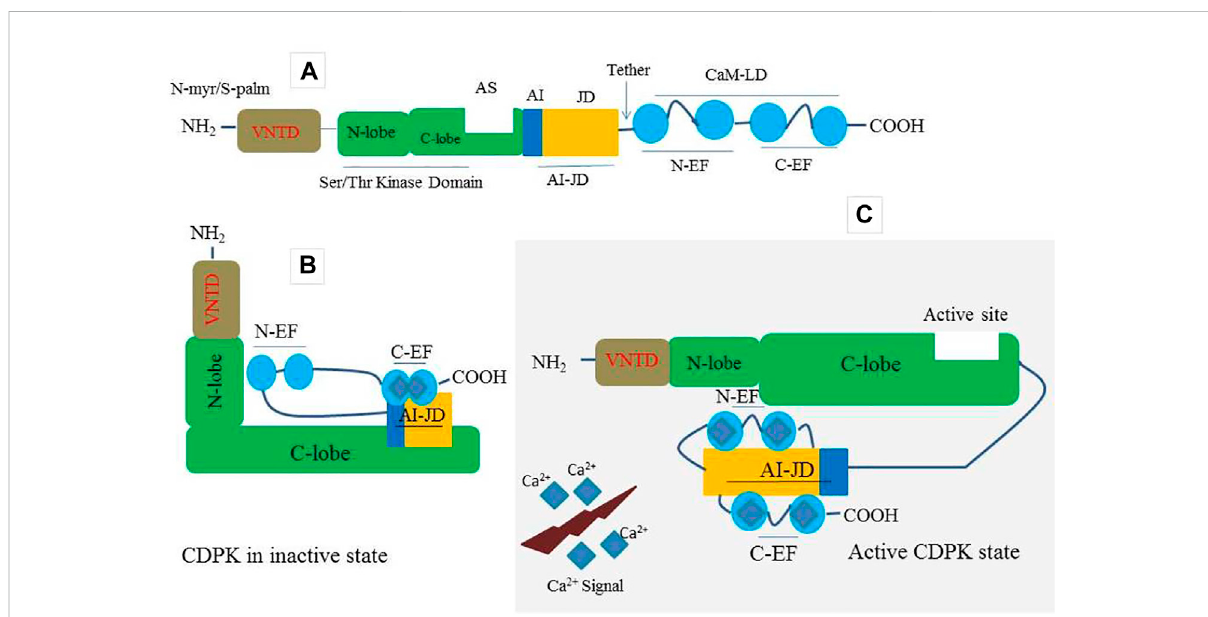
FIGURE 1 A prototype of CDPK protein structure and its decoding mechanism. (A) A typical CDPK comprises a variable N-terminal domain (VNTD) which contains (Myristoylation site and Palmitoylation site), serine/threonine kinase domain, active site (AS), auto-inhibitory junction domain (AI-JD) made up of [auto-inhibitor (AJ) and junction domain (JD)], and a C-terminal CaM-like domain (CaMLD) which harbor (four EF-hands) for Ca 2+ binding. (B) CDPKinaninactivestatewithAIactingasarestrainingmolecule.Inarestingposition,theAI-JDinteractswiththeC-lobeandC-EFbybindingin theASwhilestheN-lobeinteractswithN-EF. (C) CDPKinanactivestate.UponincreaseincytosolicCa 2+ concentration,theAI-JDdetachesfromthe ASasaresultoflargeconformationchangesthatoccurredinthekinasesdomain.Ca 2+ ionsbindwiththeC-terminallobe(C-EF)andN-terminallobe (N-EF) and then interact with AI-JD on both